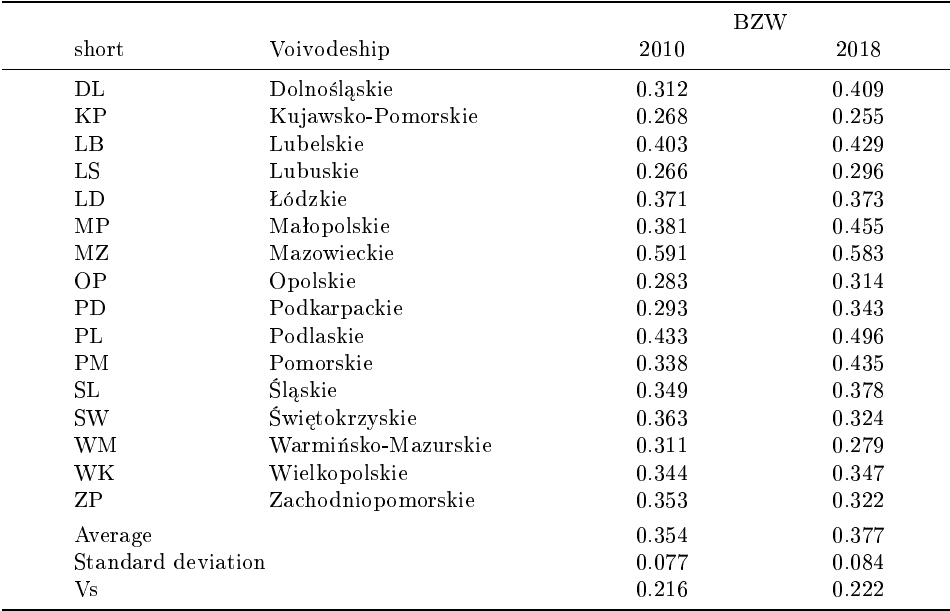
Table 6: The level of social inequalities in LGU